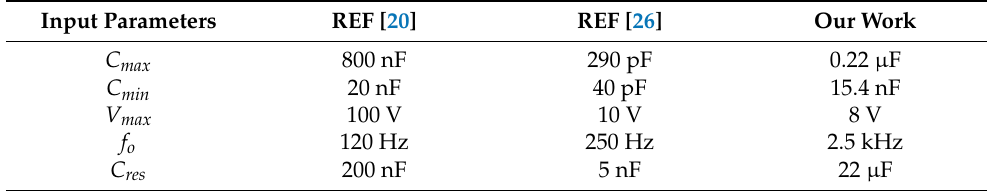
Table 2. Input parameters of different designs of electrostatic MEMS converters. Also, our design input parameters are shown for comparison.